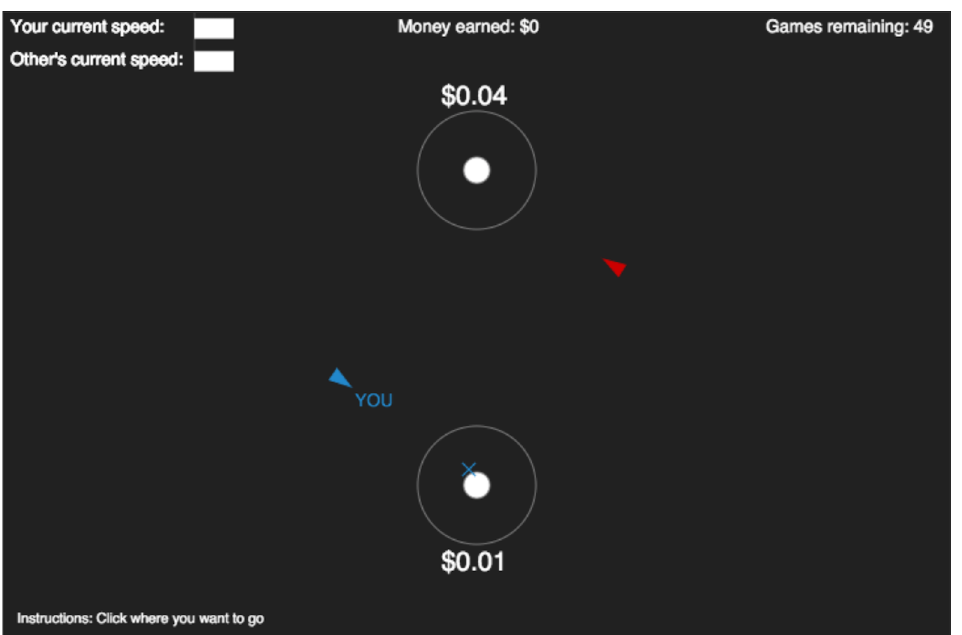
Fig 1. Screenshot of the first round of the experiment. The colored triangles represent the players ’ avatars, the white circles represent targets (labeled by their corresponding payoffs), the outer shell gives the ‘ tie radius ’ , and the colored cross shows a player their current ‘ destination ’